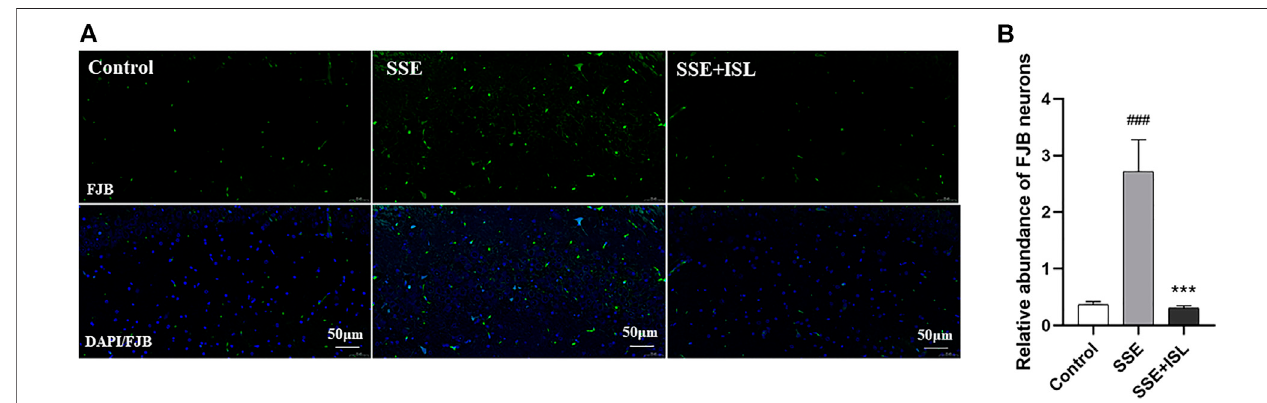
FIGURE 2 | ISL alleviated Semen Strychni-induced neurodegeneration in the hippocampus. The immuno fl uorescence images (A) and respective relative IOD histograms (B) of FJB-positive neuronal cells in the CA1 region of rat brains. The density values are expressed in arbitrary units as the means ± standard deviation (mean ± SD). Signi fi cance: ### p < 0.001 (SSE group vs. Control group); *** p < 0.001 (SSE + ISL group vs. SSE